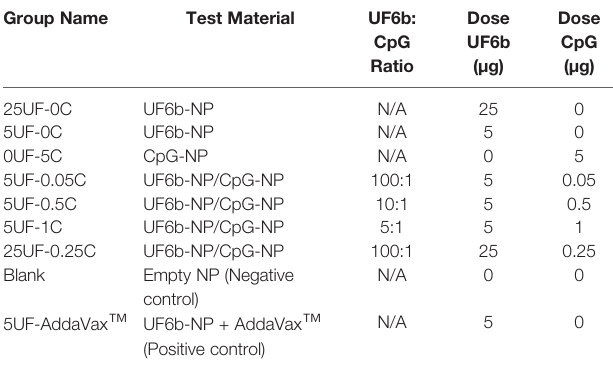
TABLE 1 | Antigen/adjuvant nano-constructs used for mouse immunizations ( s.c.